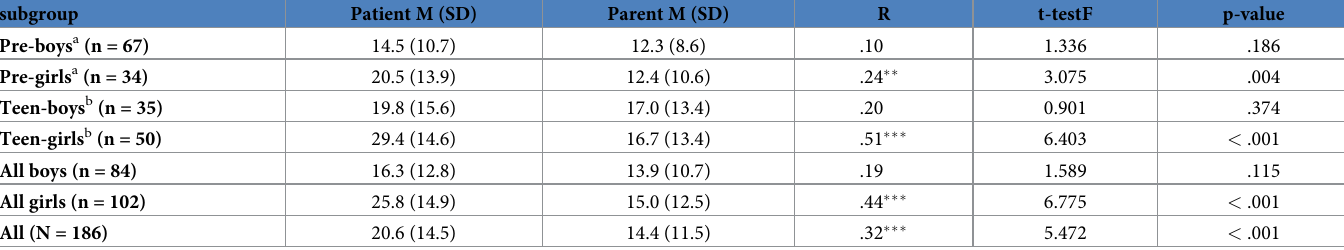
Table 1. MFQ means, standard deviations and independent t-test as per child versus parent ratings separately for boys and girls and for children and adolescents. subgroup Patient M